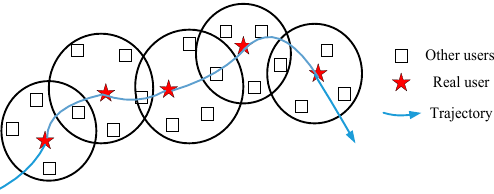
Figure 3. The schematic of location correlation attack (LCA).